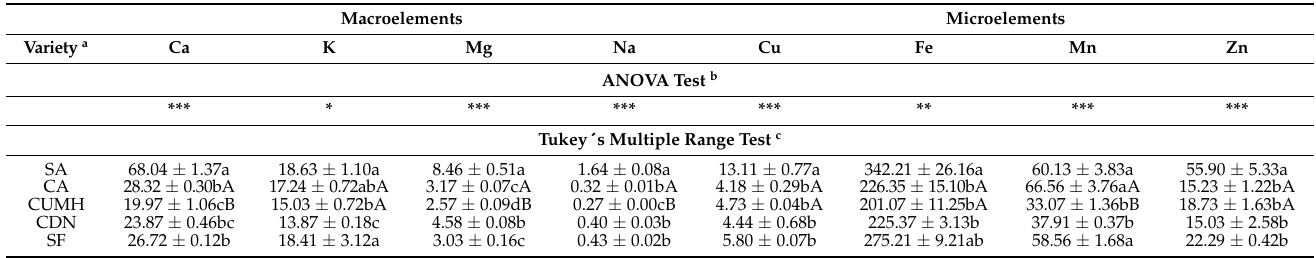
Table 3. Macro (Ca, K, Mg, and Na; g Kg − 1 dw) and microelements (Cu, Fe, Mn, and Zn; mg Kg − 1 dw) of Ficus carica